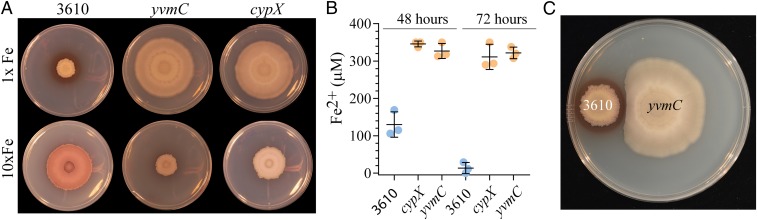
Pulcherriminic acid production modulates local iron levels. (A) NCIB 3610 and the cypX (NRS5532) and yvmC (NRS5533) deletion strains were grown at 30 °C on MSgg agar containing either 50 μM FeCl3 (1×) or 500 μM FeCl3 (10×) for 120 h before imaging. (B) The level of available ferrous and ferric iron in the agar was detected using a ferrozine assay. The bar represents the average of the biological repeats that are presented as individual points; the error bars are the SD. The starting concentration in the agar was 500 μM FeCl3 and the maximum detection limit in these conditions was 350 μM. (C) Biofilms of NCIB 3610 and yvmC (NRS5533) were inoculated onto a 15-cm-diameter MSgg (1.5% wt/vol agar) plate and incubated at 30 °C for 120 h before imaging.